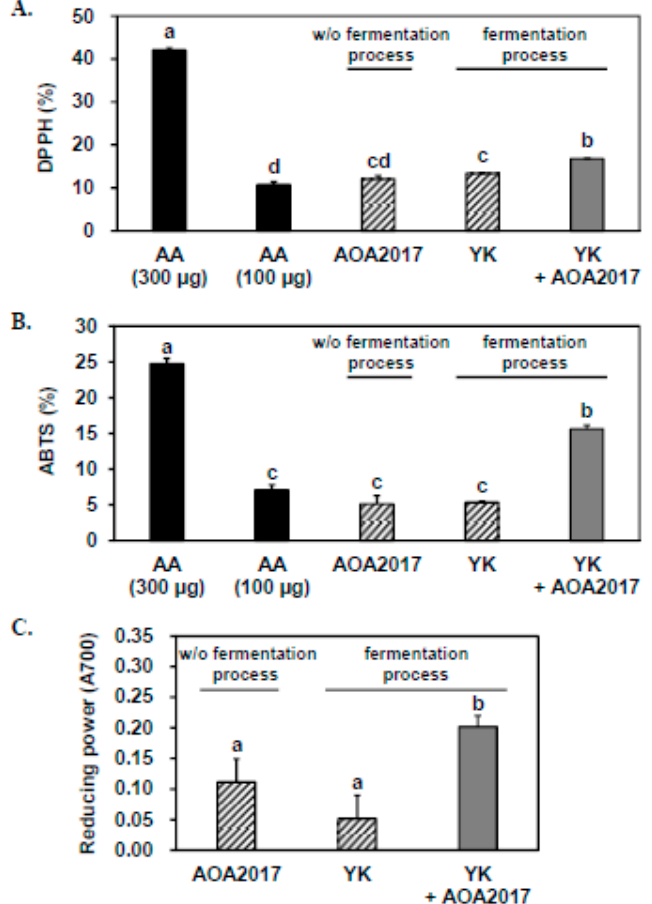
Figure 1. Effect of fermentation using Pediococcus pentosaceus AOA2017 on the antioxidant activity of Yak-Kong (YK). The antioxidant activity was compared among three samples: the bacterial broth ( P. pentosaceus AOA2017) without the fermentation process, the extract of YK applied with the fermentation process without P. pentosaceus AOA2017, and the extract of YK fermented by P. pentosaceus AOA2017. ( A ) Antioxidant activity measured by 1,1-diphenyl-2-picrylhydrazyl (DPPH) free radicals, ( B ) Antioxidant activity measured by 2,2 ′ -azinobis-(3-ethylbenzothiazoline-6-sulphonic acid, ABTS) free radicals, and ( C ) the reducing power. Data are expressed as mean ± SD ( n = 3). Data were analyzed using one-way analysis of variance (ANOVA) followed by Tukey’s honest significant difference test. Different letters (a, b, c, and d) on the top of the bars indicate significant differences ( p < 0.05) among different treatments. AA, ascorbic acid; YK, Yak-Kong; AOA2017, P. pentosaceus AOA2017; w/o, without.